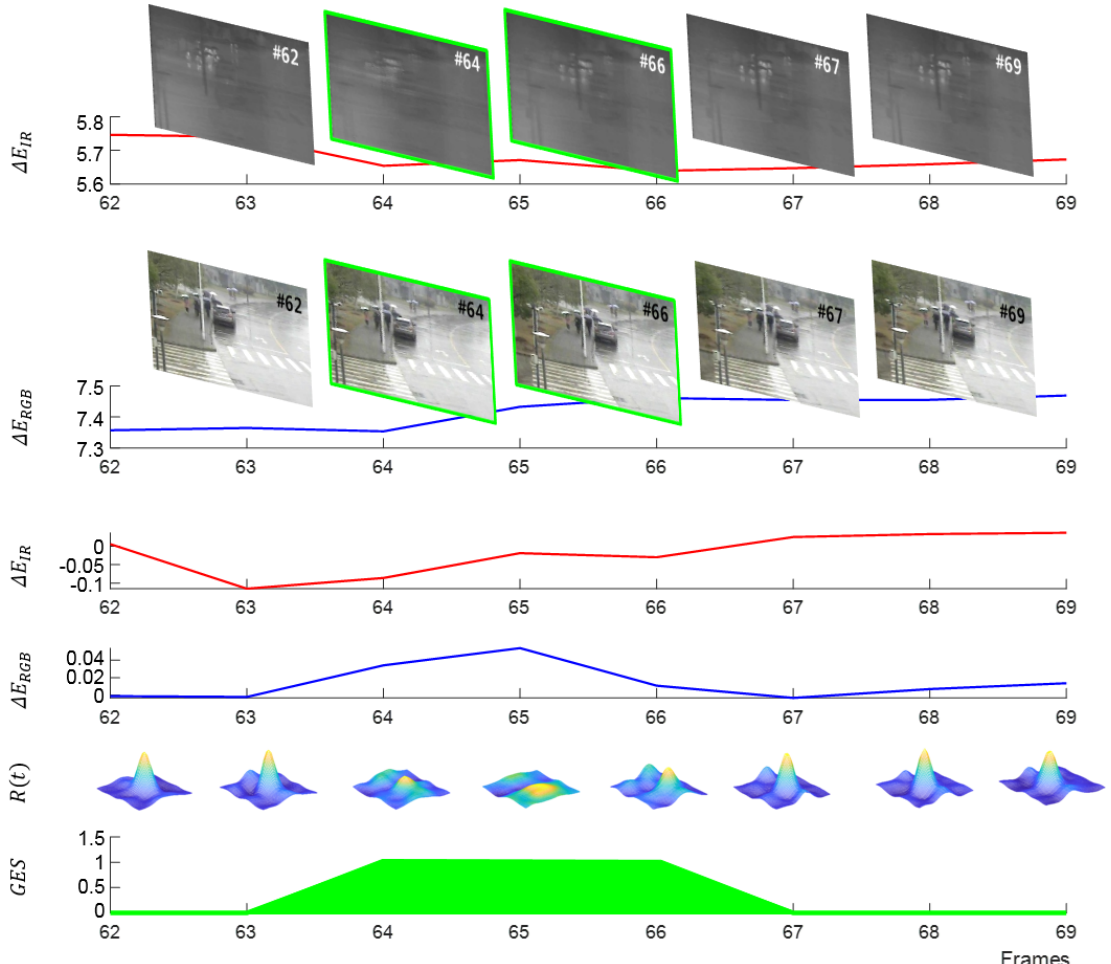
Figure 3. Example of the camera movement detection (camera movement happens between the frames #64 an #66, bordered with green). During that period, ∆ E RGB and ∆ E IR are increased, and R is significantly lower, which triggers the camera motion